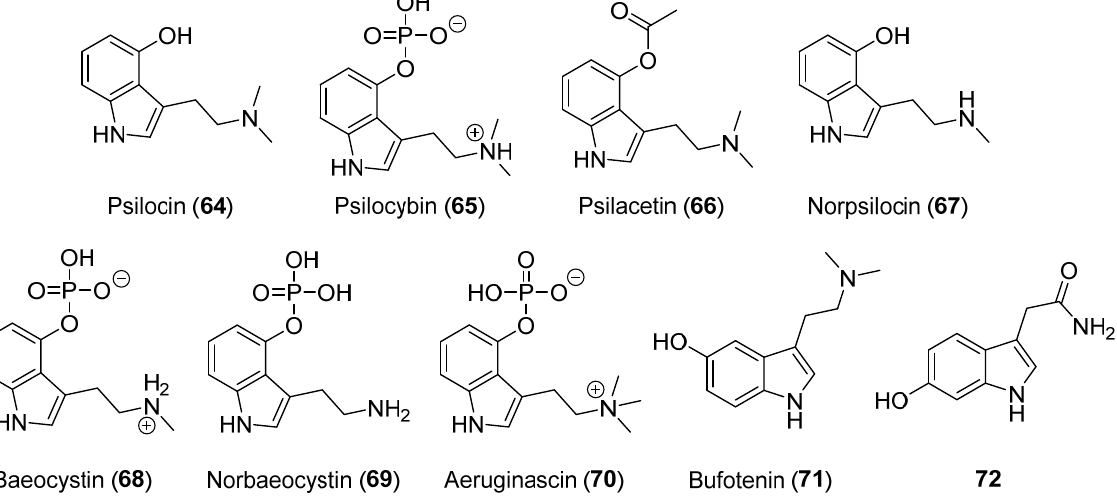
Figure 5. Already-known bioactive indole alkaloids produced by mushrooms ( 64 – 72